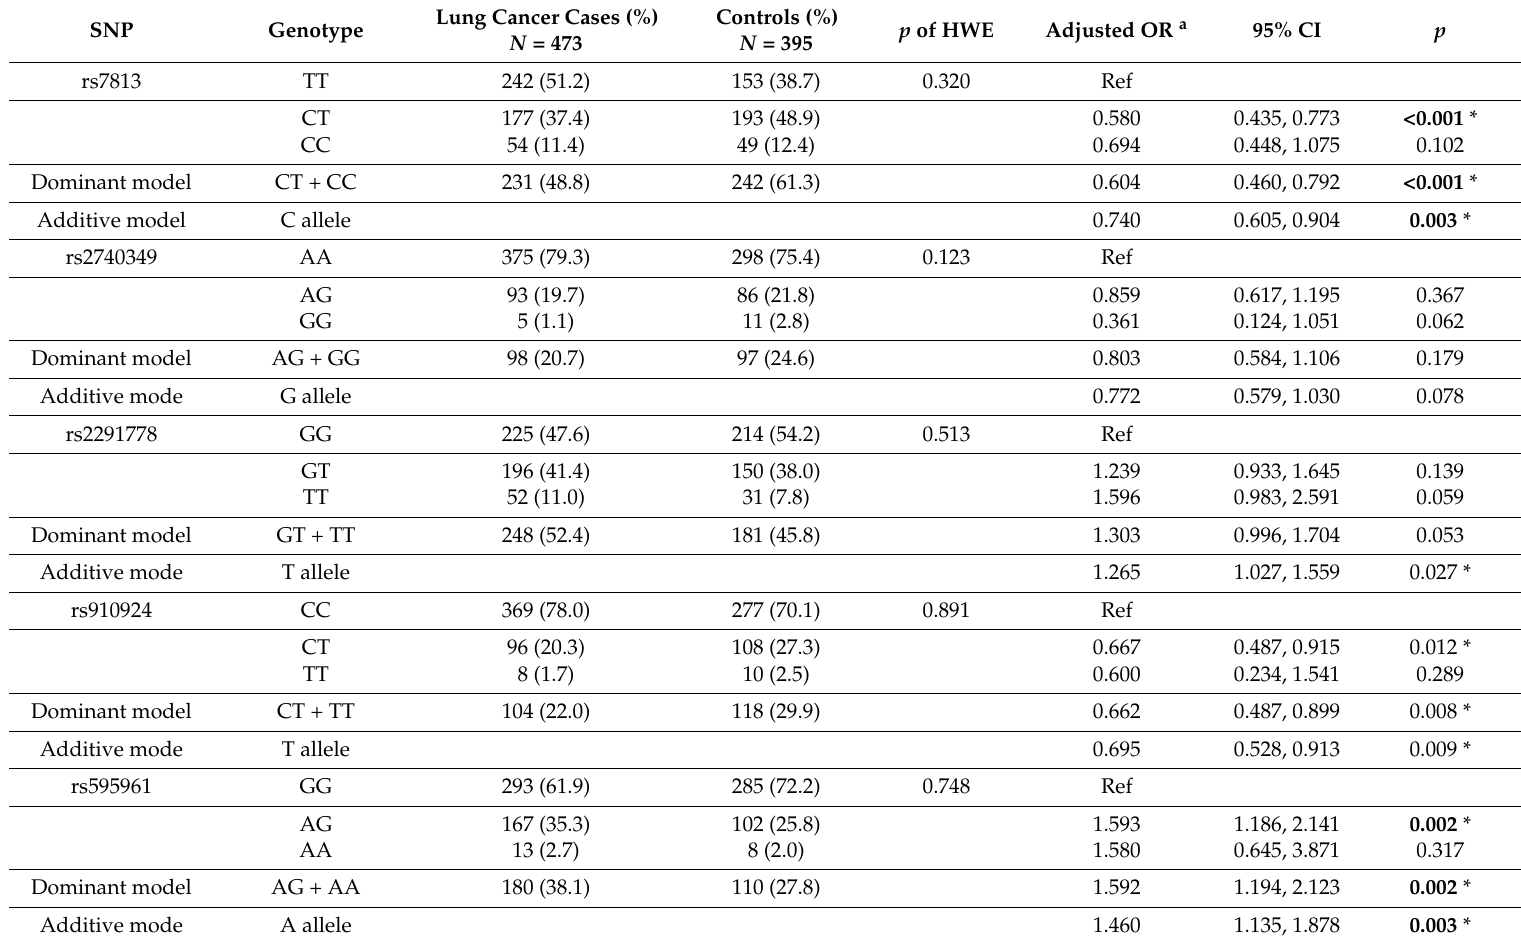
Table 3. Distribution of genotypes and ORs for lung cancer cases and cancer-free